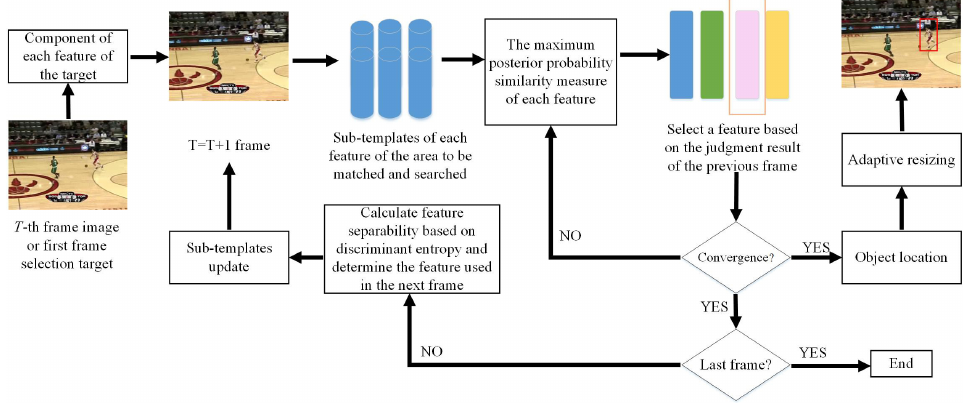
Figure 1. The framework of object tracking algorithm based on self-adaptive feature selection. The framework mainly includes three